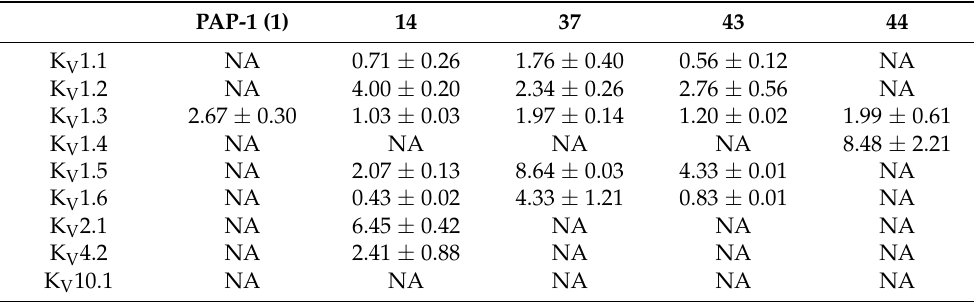
Table 4. IC 50 values [ µ M] for analogs PAP-1 , 14 , 37 , 43 , and 44 on relevant voltage-gated ion channels. IC 50 values were determined with HiClamp Xenopus laevis heterologous expression system